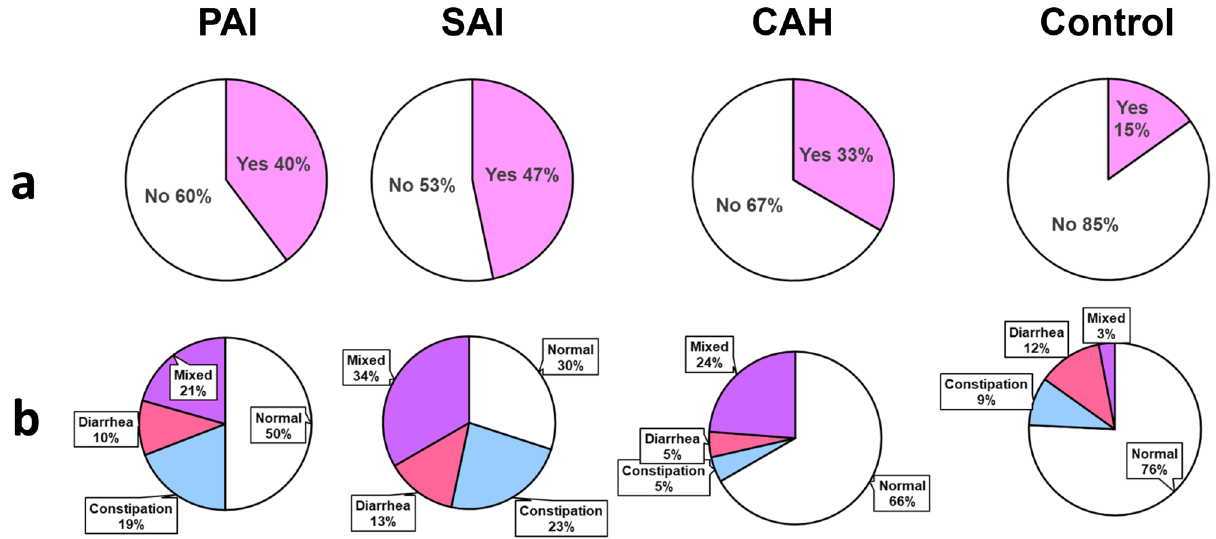
Figure 2. Digestive symptoms reported by patients in each adrenal insufficiency subgroup and control group. ( a ) Percentage of patients with abdominal pain at least once a week during the last three months (pink: yes (abdominal pain), white: no abdominal pain); ( b ) Type of bowel habit according to the Bristol stool scale (normal: white, constipation: blue, diarrhea: red or mixed: purple). PAI primary adrenal insufficiency, SAI secondary adrenal insufficiency, CAH congenital adrenal